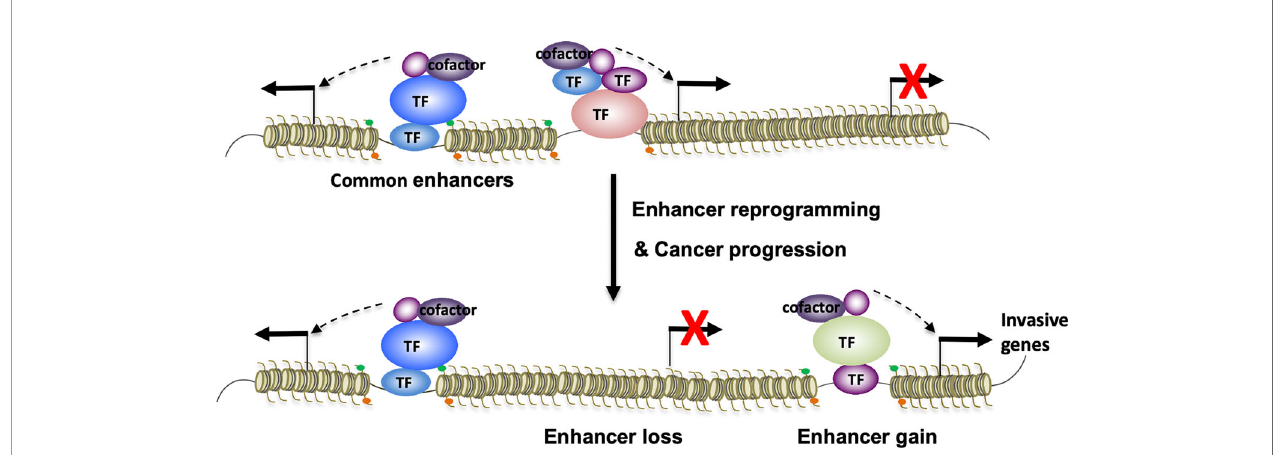
FIGURE 1 | Enhancer reprogramming mediated by context-speci fi c TF-TF interactions promotes lineage plasticity and cancer progression. In response to various signals, interactions of oncogenic TFs on enhancers might undergo context-speci fi c changes. These changes can architecturally reprogram TF-bound enhancers through enhancer loss and gain, resulting in transcriptional transitions that promote lineage plasticity and cancer therapy resistance and metastatic